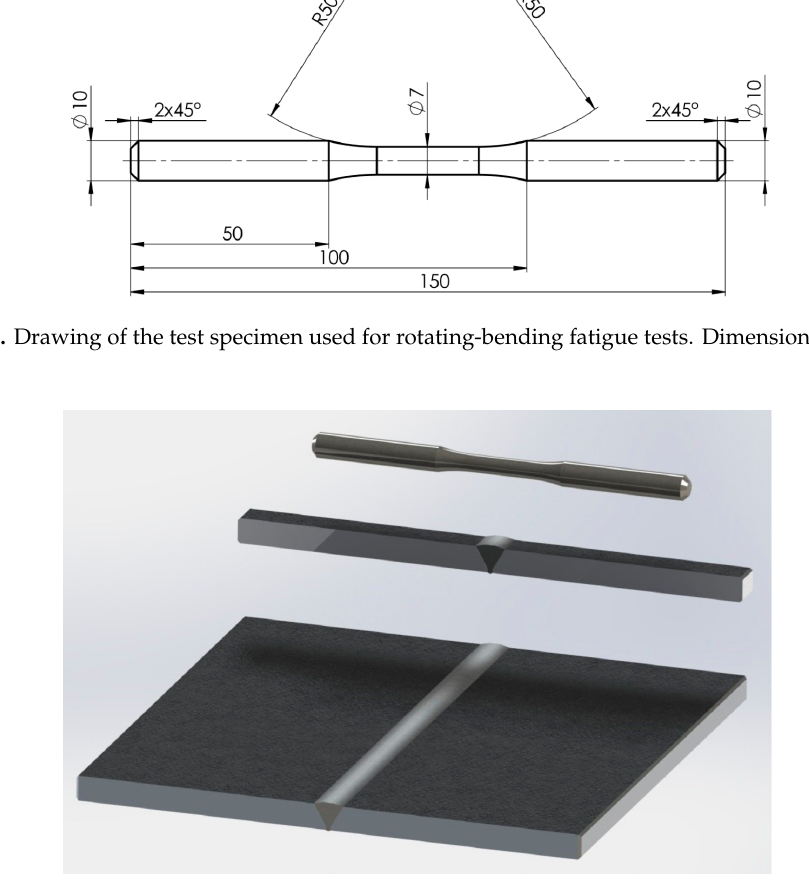
Figure 3. Position of the welded joint in the final rotating-bending fatigue test specimen.